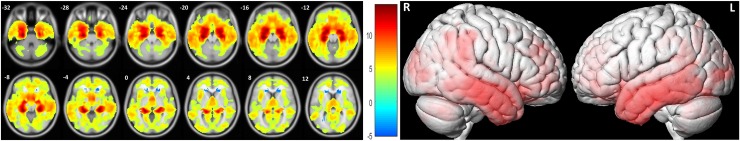
Results showing significant GM differences between the AD and HC groups.